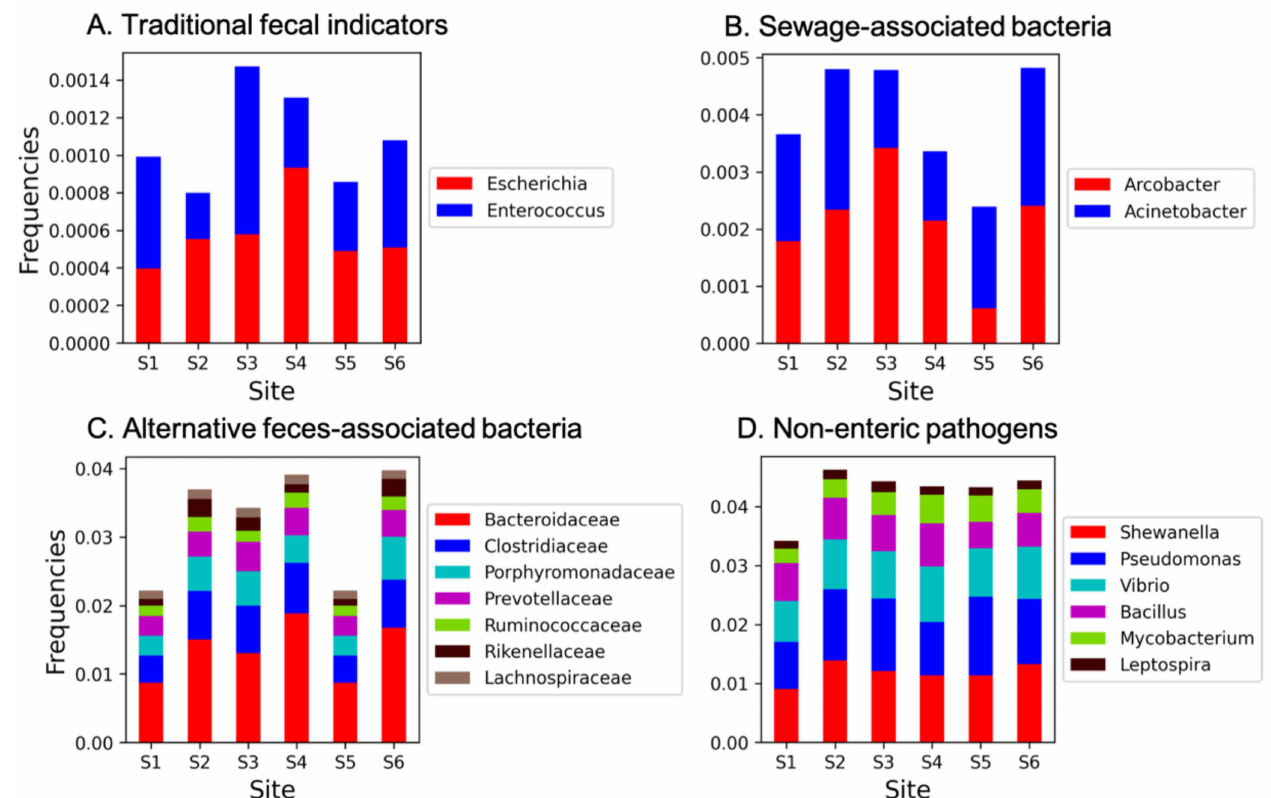
Figure 2. ( A ) Frequencies of traditional, ( B ) sewage-associated, ( C ) alternative feces-associated, and ( D ) other non-enteric potential pathogens at each sampling station. All taxa reported in the Materials and Methods section and not reported in Figure legend were not found in our dataset. Frequencies were determined by dividing the number of sequences whose annotations contained the selected keyword(s) by the total number of sequences in that Subsystems database (e.g.,